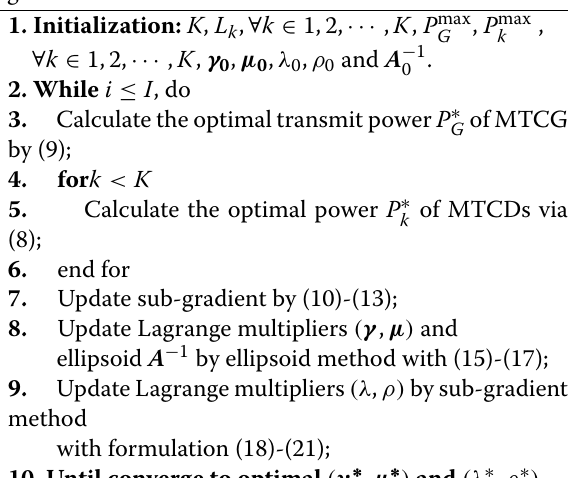
Algorithm 1 Proposed Lagrange-base Power Allocation